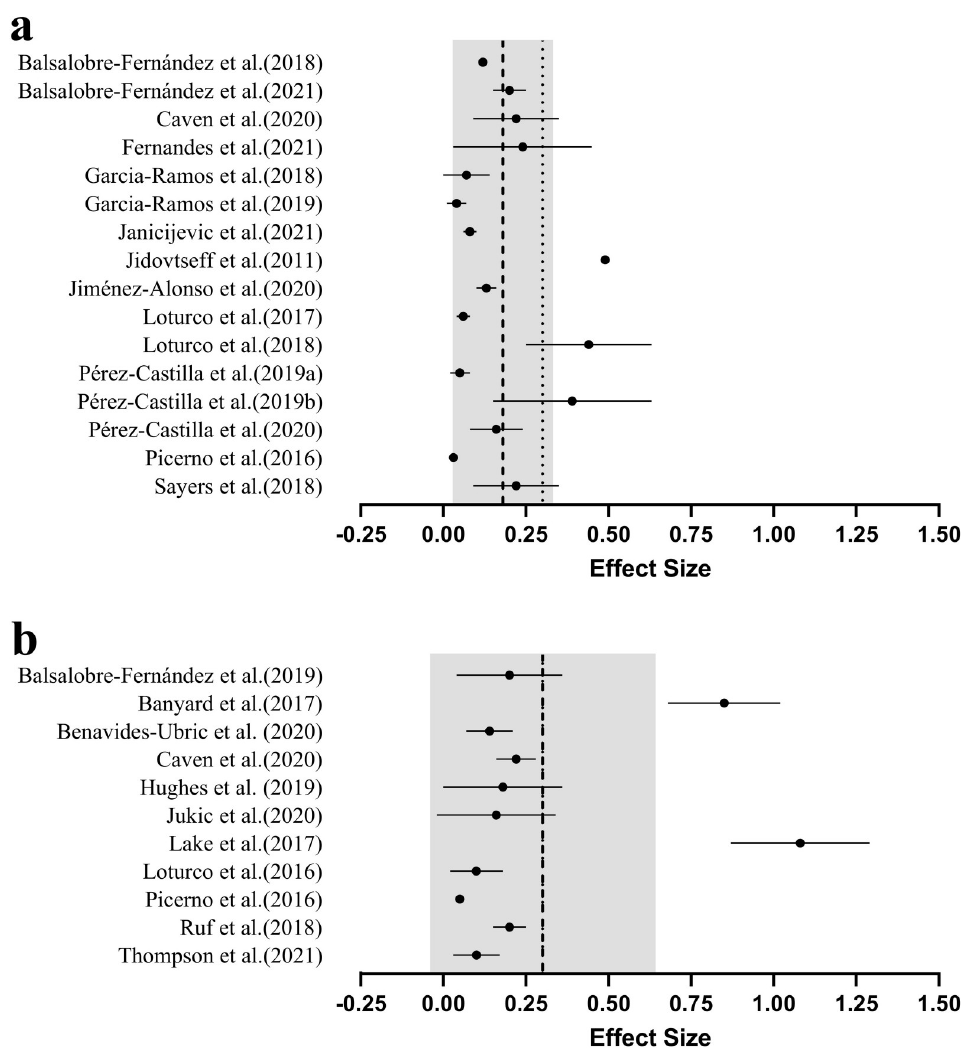
Fig 4. Mean ( ● ) effect sizes ( ± SD), grouped average (---) and recommended maximum effect size ( ��� ) for difference between predicted and actual 1RM by exercise group examined; a.) upper body exercises, b.) lower body exercises. The grey band represents the standard deviation of the pooled effect sizes. Note : Effect sizes closer to zero indicate greater validity (i.e., smaller difference between actual and predicted